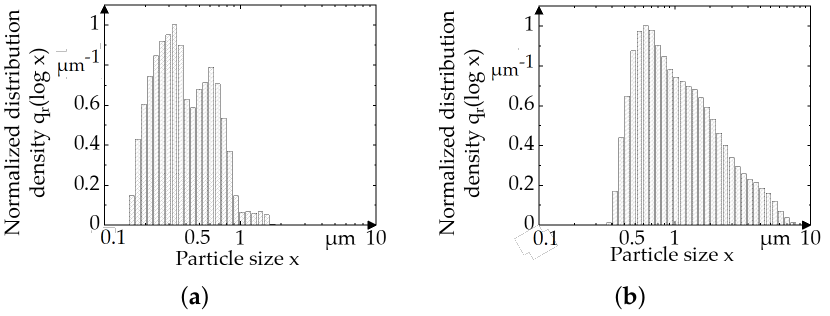
Figure 9. Particle size distribution of the aqueous dispersions containing 10 m% graphite nanoparti- cles and ( a ) 15 m% PVP (see Table A13) and ( b ) 40 m% TX-100 (see Table